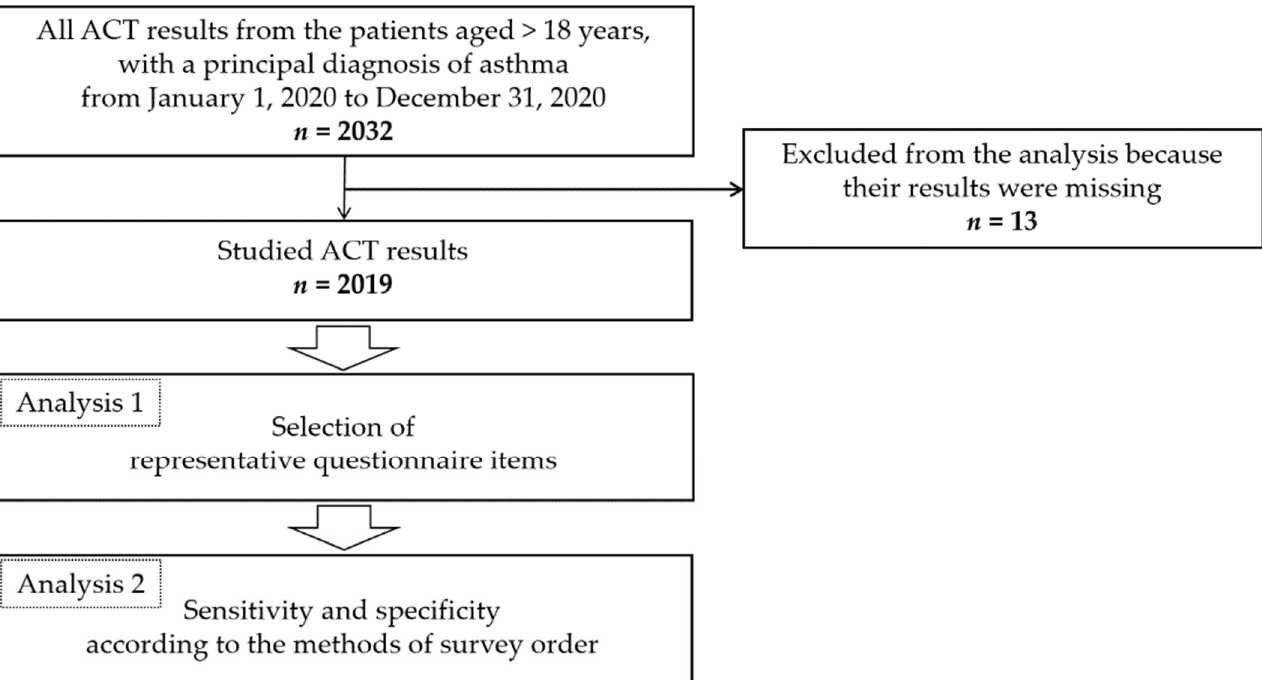
Figure 1. In the ACT-based evaluation, the analysis was divided into “Analysis 1” for selecting rep- resentative questionnaire items and “Analysis 2” to determine the combination for investigation.